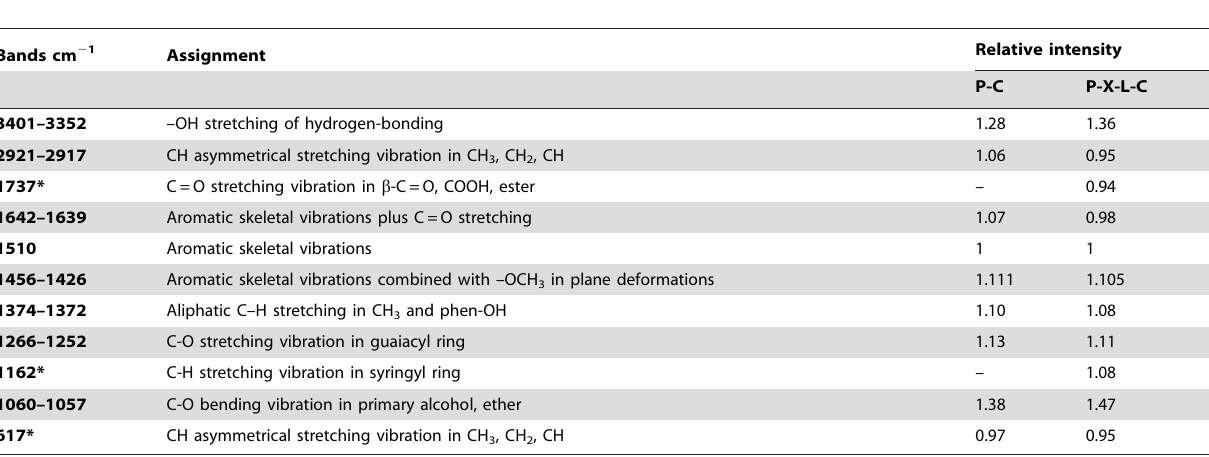
Table 4. Signals assignment of hand sheets in FTIR spectra and their relative intensity for untreated (P-C) and treated (P-X-L-C) pulp.